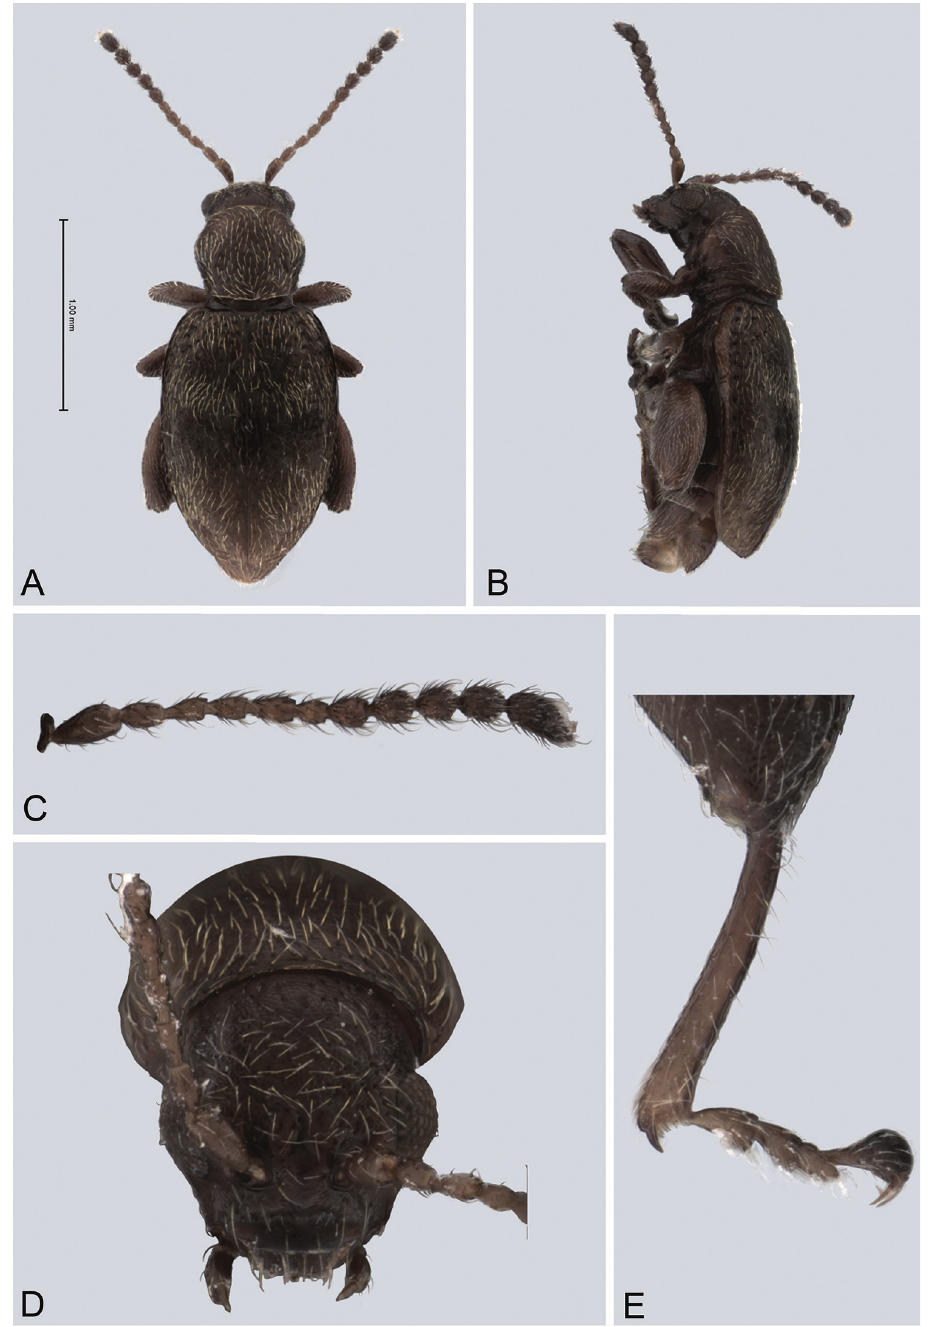
Figure 15. Andersonoplatus lagunanegra . A Habitus dorsal B Habitus lateral C Antenna D Head, frontal view E Hind